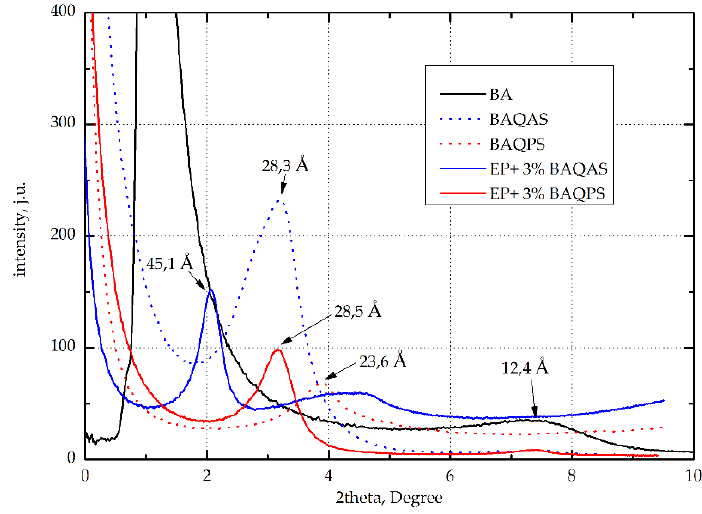
Figure 12. Wide-angle X-ray scattering (WAXS) curves of bentonites: unmodified BA, modified BAQAS and BAQPS, and cured epoxy compositions containing 3 wt.% BAQAS and BAQPS.